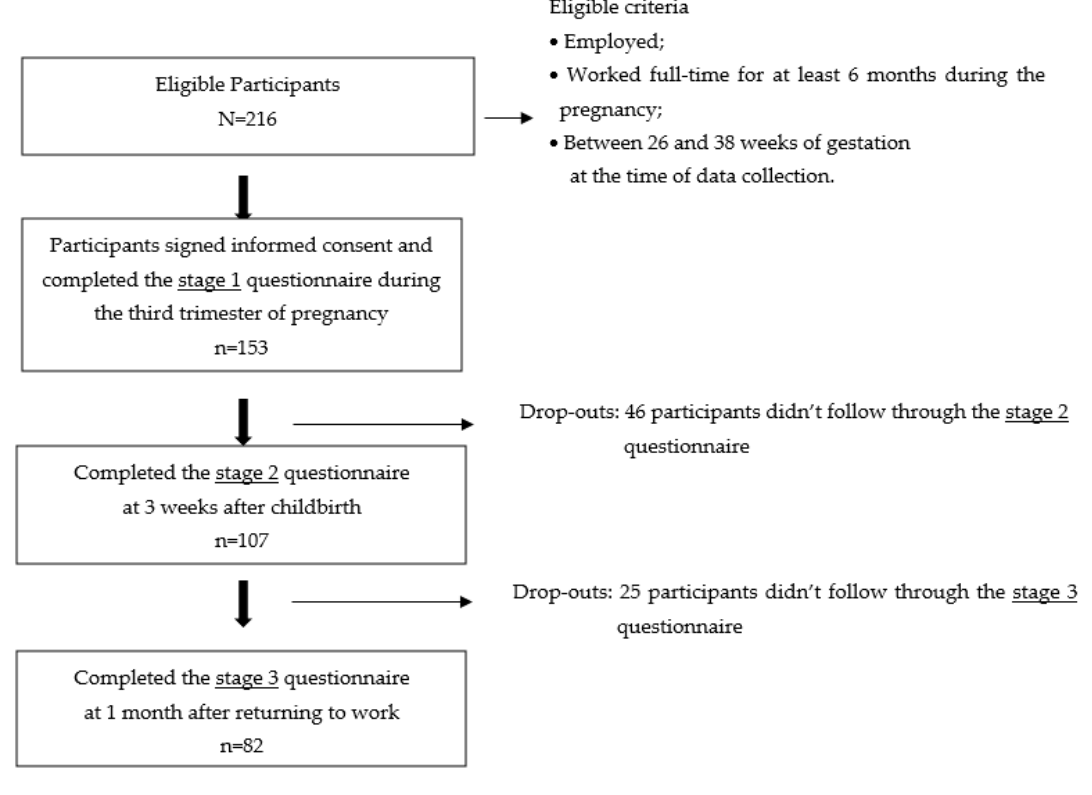
Figure 1. The study flow